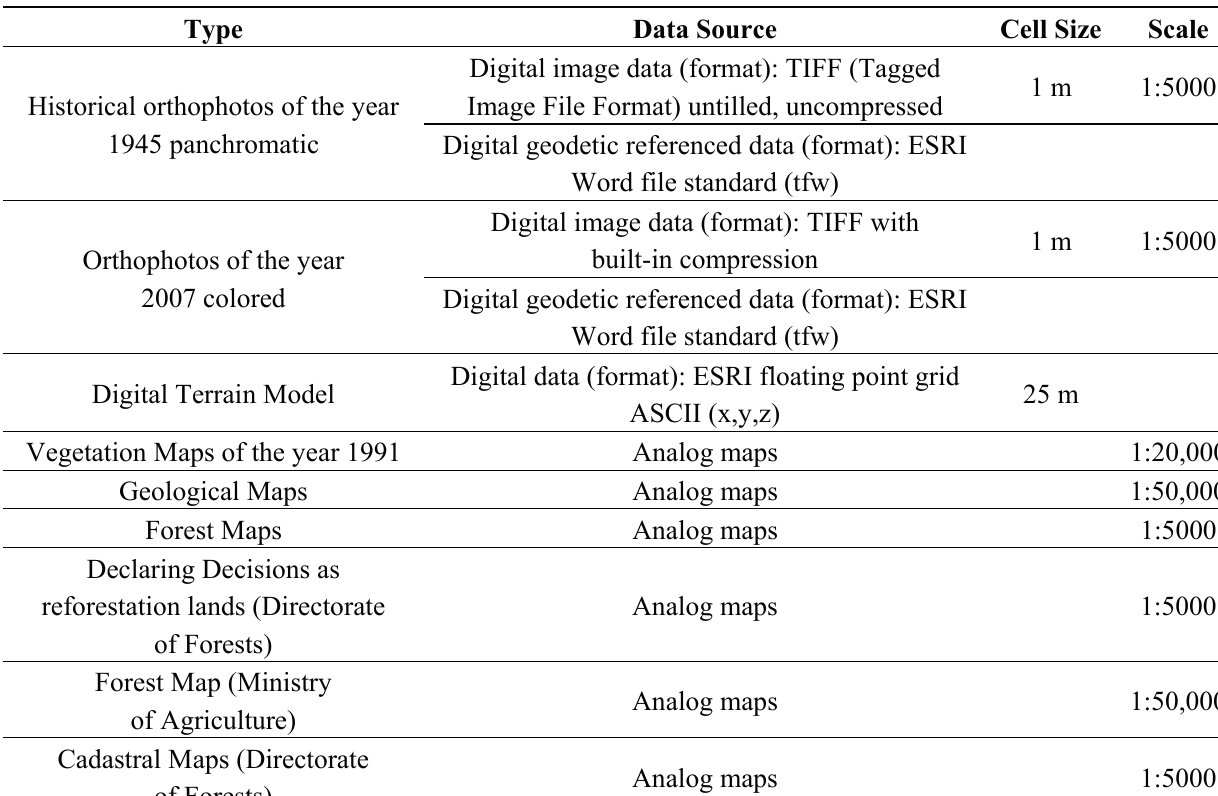
Table 2. The used